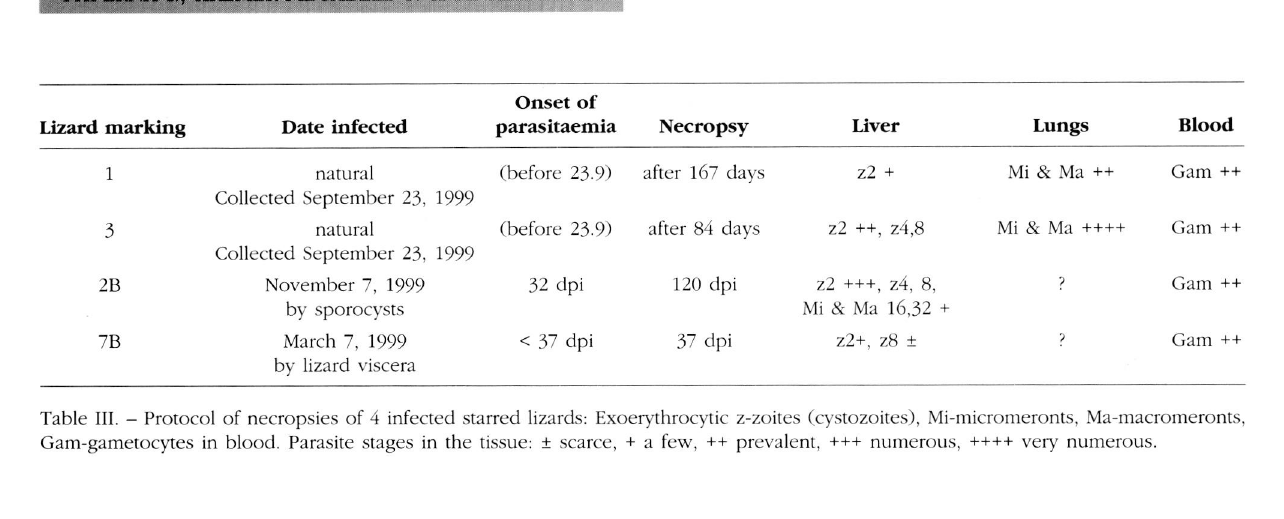
tion, macro- and micromeront infection coincided with the liver infection (Table